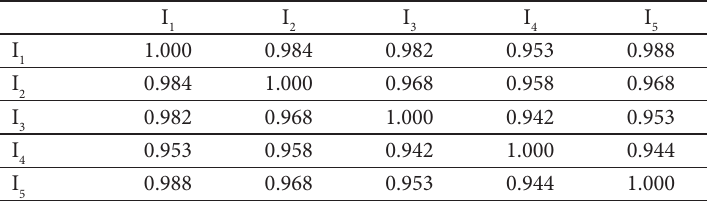
Table 2. Pearson correlation coefficient of input variables